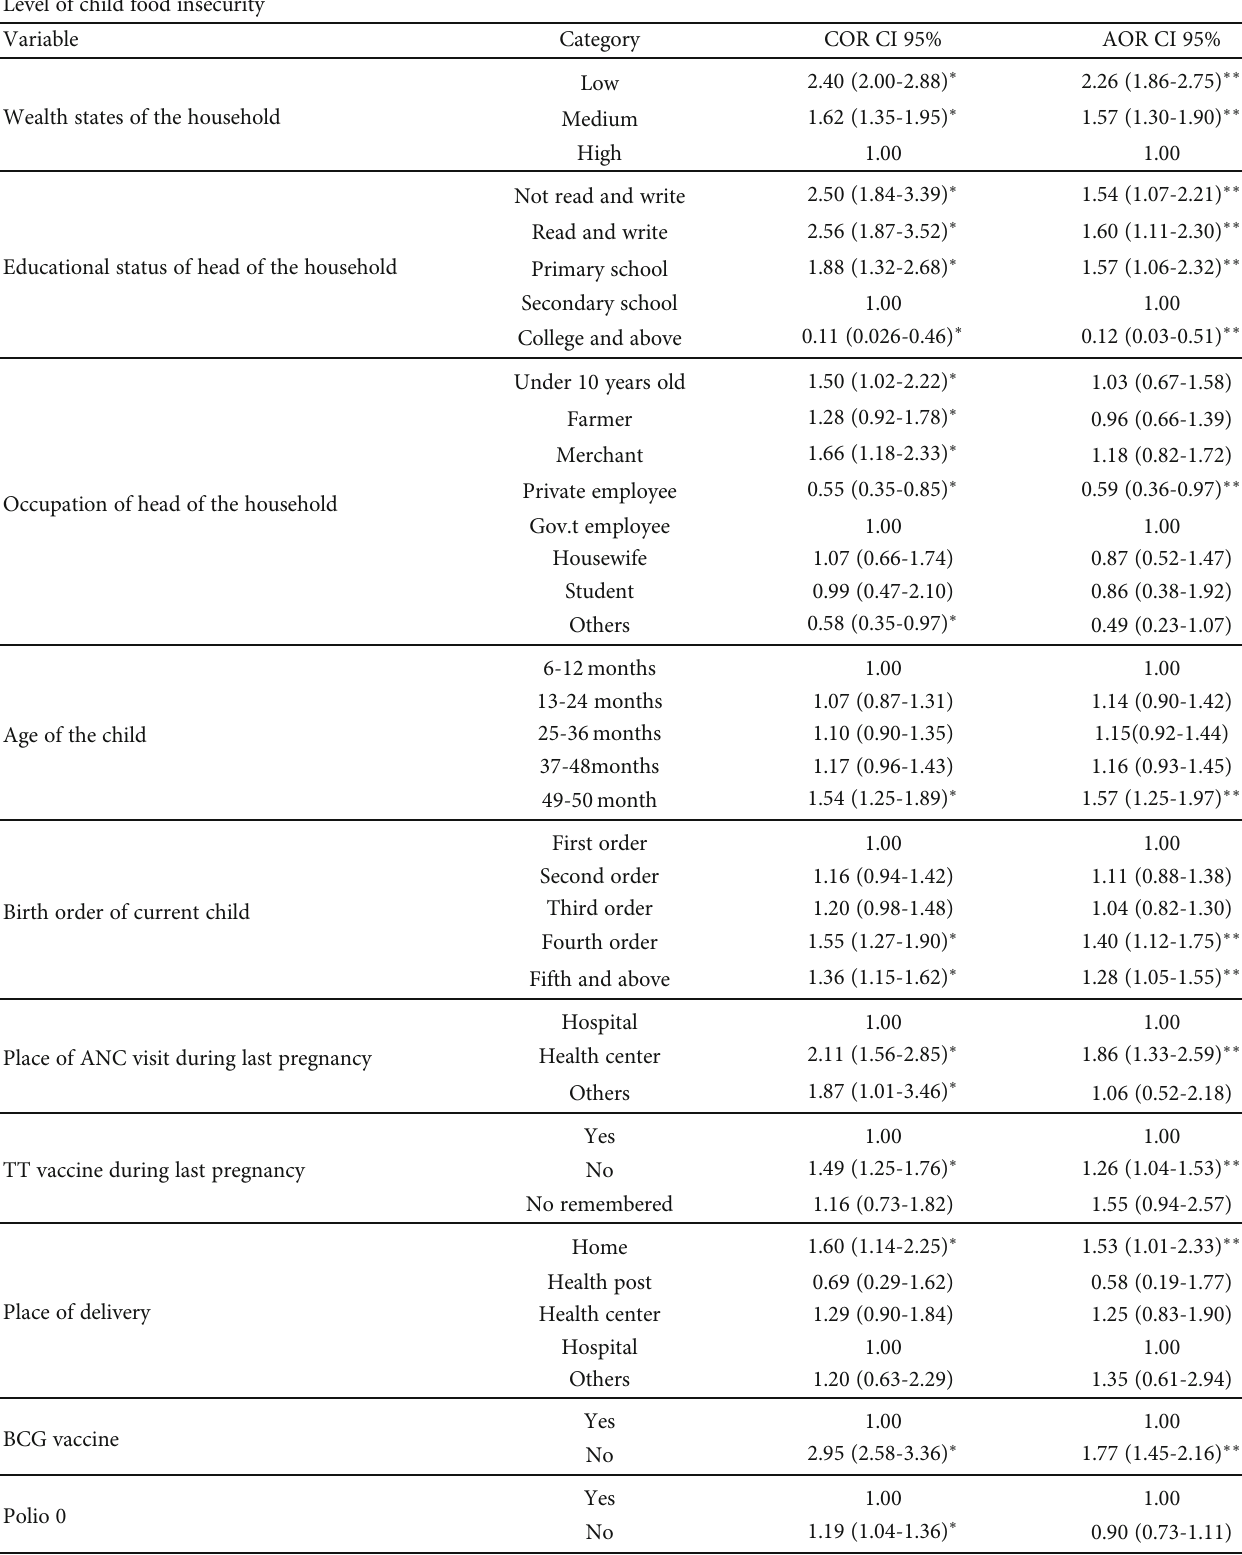
Table 4: Crude and adjusted ordinal logistic regression table of child food insecurity level in Dabat HDSS site, North West Ethiopia: April